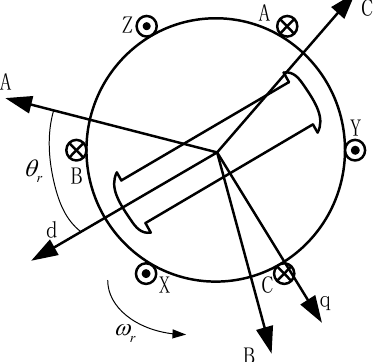
Figure 2. Internal structure of the PMSG.